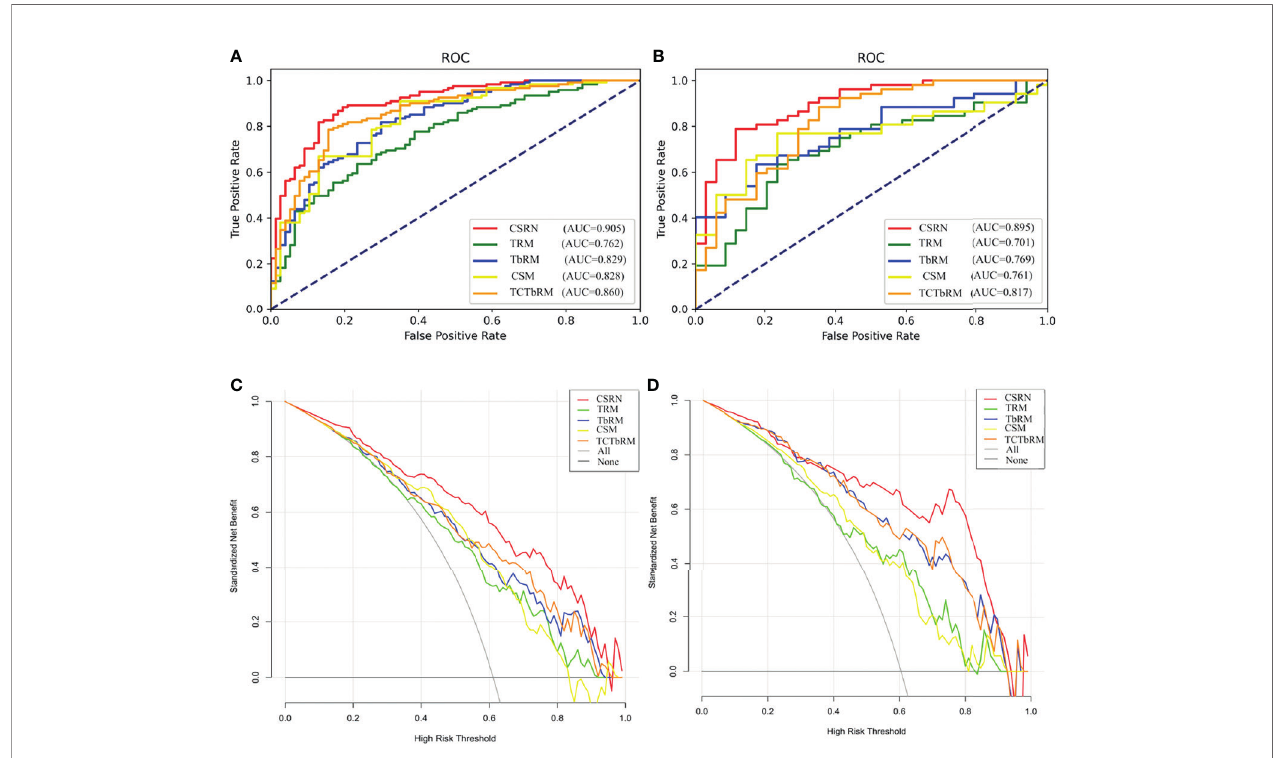
FIGURE 8 | Performance of the fi ve models. (A) ROC curve of the training set; (B) ROC curve of the test set; (C) DCA curve of the training set; (D) DCA curve of the test set. ROI, region of interest; DCA, decision curve